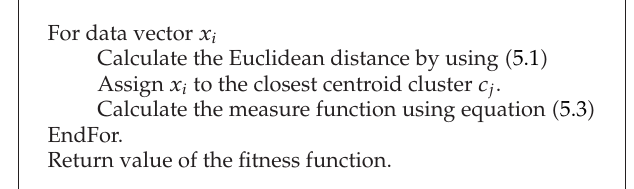
Algorithm 3: Main steps of the fitness